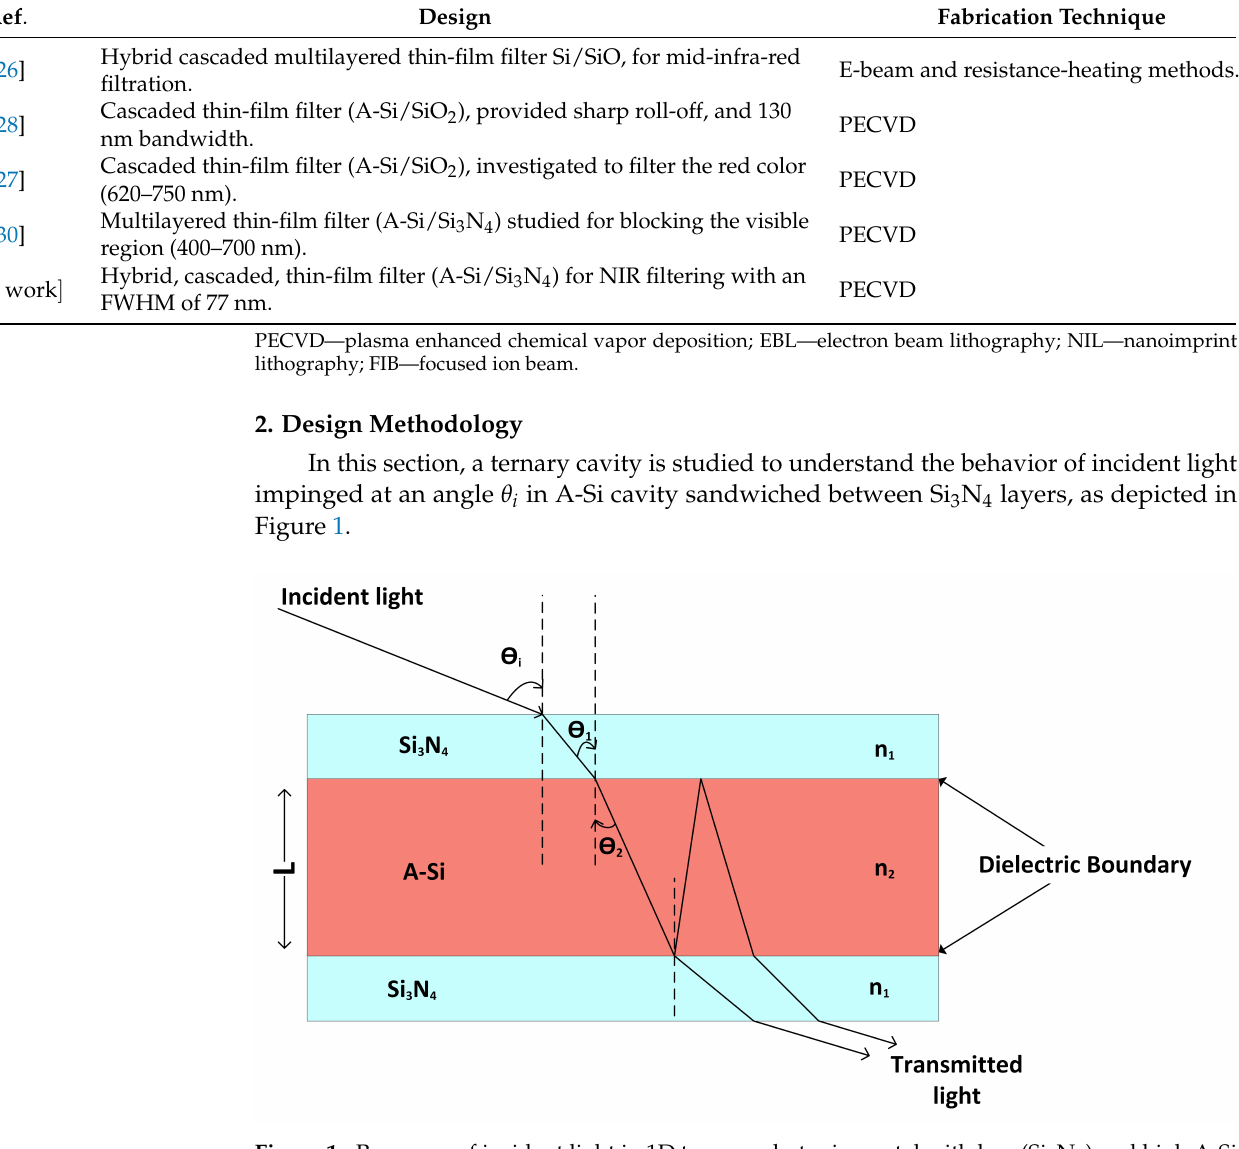
Figure 1. Response of incident light in 1D ternary photonic crystal with low (Si 3 N 4 ) and high A-Si refractive indices